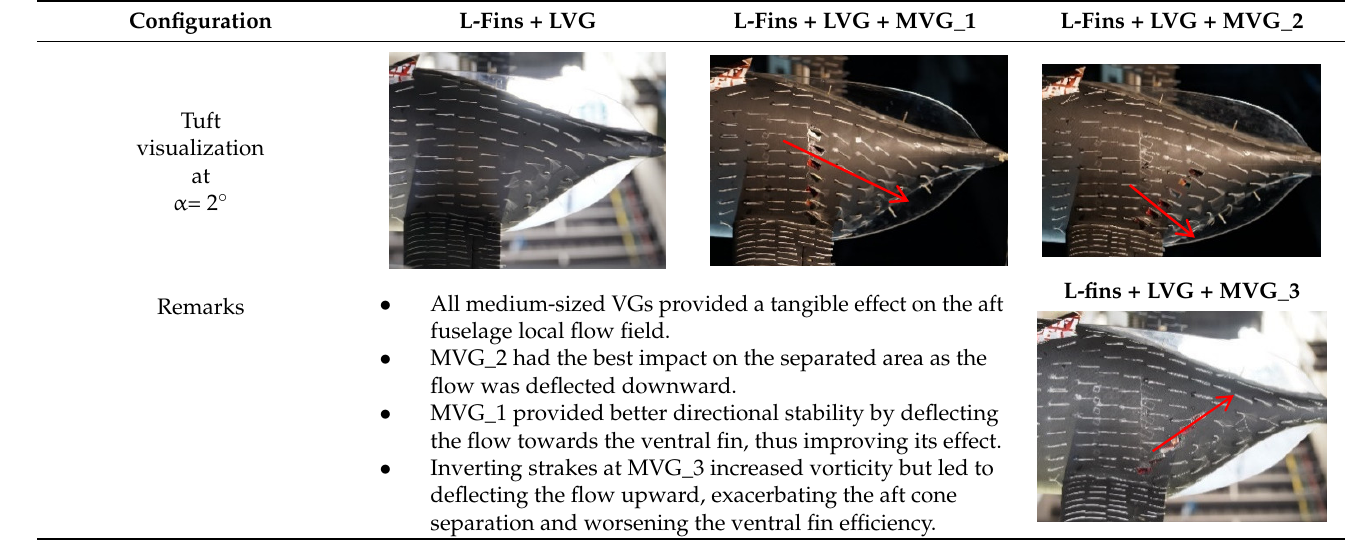
Table 4. Tuft visualization of the aft fuselage with small VG installed in configurations 1 and 2.